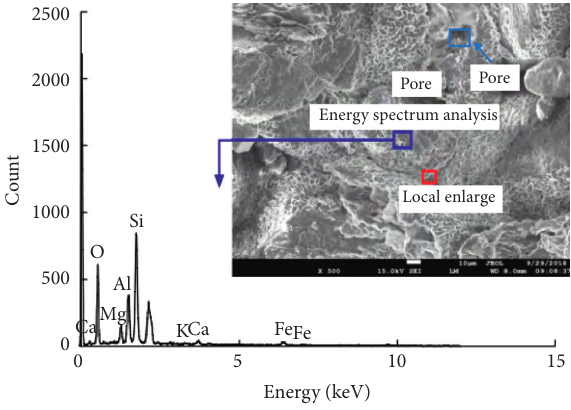
Figure 1: Sandstone XRD diffraction Table 1: Average physical and mechanical parameters of sandstone.